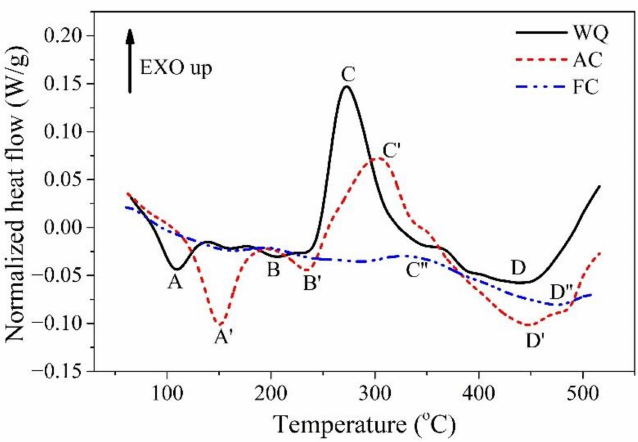
Figure 2. Normalized heat flux of the 2A97 Al alloy solution treated at 520 ◦ C for 1 h and cooled by different